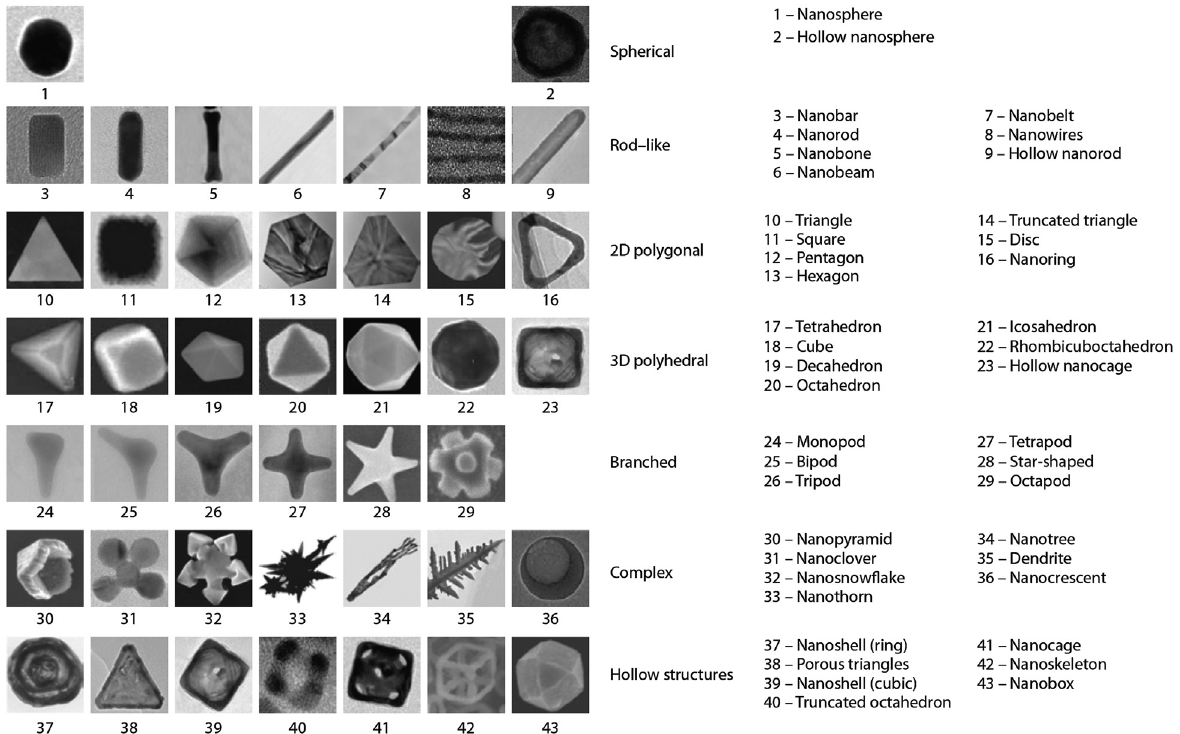
Figure 15 Toolbox of metallic nanoparticles in different shapes, dimensionality, and geometries, which serve as building blocks to self- assemble plasmonic metamaterials. The geometric order of the nanoparticles gradually increases from left to right in each row in terms of aspect ratios, number of sides, facets, or branches. The figure is adopted from Ref. [205] with